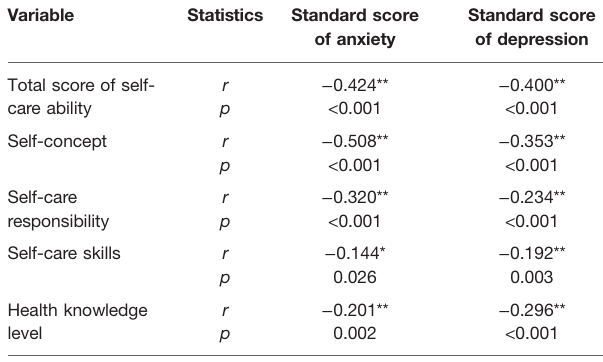
TABLE 2 | Correlation between self-care ability and psychological status of discharged patients with hepatolithiasis and diabetes mellitus with T-tube ( n =240).